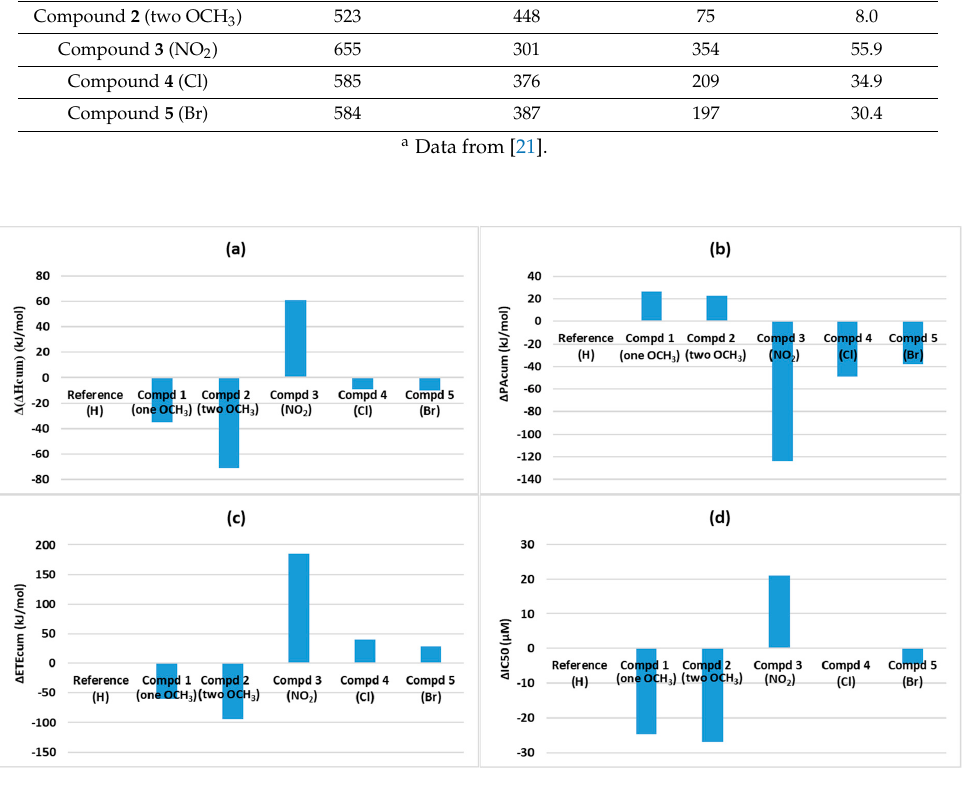
Figure 7. Correlation between IC50 and ∆ H cum ( a ), IC50 and PA cum ( b ), and IC50 and ETE cum ( c ).